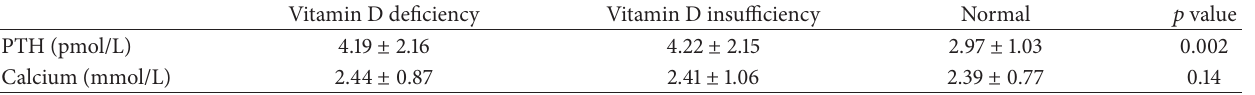
Table 2: Mean ± standard deviation of parathyroid hormone (PTH) and adjusted calcium levels.